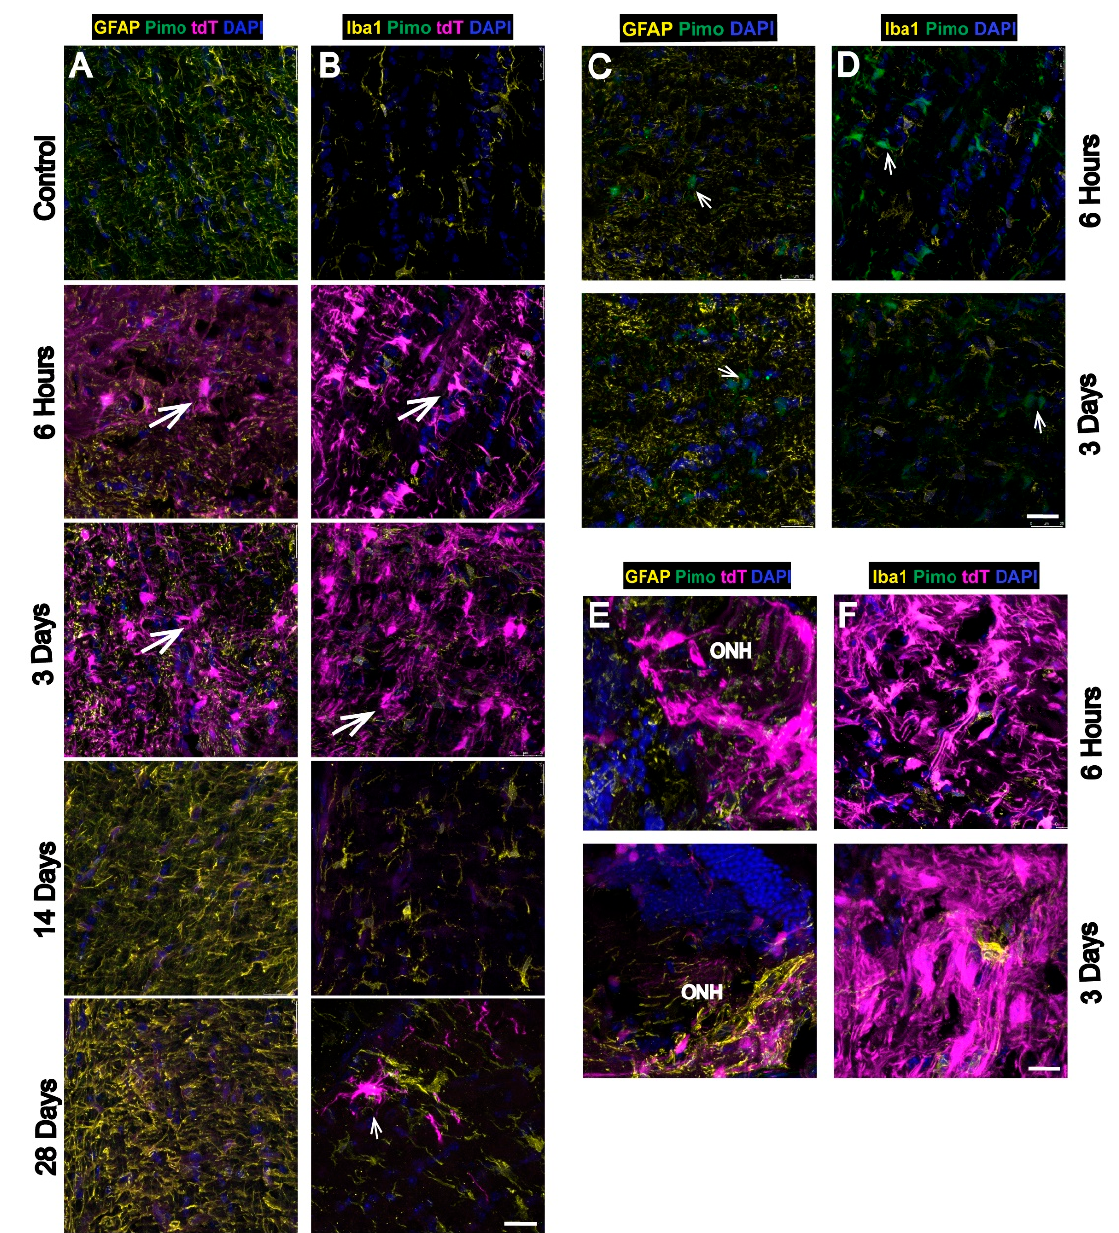
Figure 5. Hypoxic glia in the ON and ONH after OHT. Sections oriented so the globe is superior. Longitudinal sections of ON showed hypoxic glia detected 6 h, 3 d, 28 d after OHT by tdT expression colocalized with GFAP (yellow) in astrocytes (( A ), arrows) and Iba-1 (yellow) in microglia (( B ), arrow) compared with control. Pimonidazole-positive glial cells (pimo, green, arrows) were shown colocalized with GFAP in astrocytes ( C ) and with Iba1 in microglia ( D ) 6 h and 3 days after OHT. Pimonidazole was shown separately since tdT expression overrode pimonidazole labeling in A , B . ONH showed higher intensity of tdT expression than ON 6hrs and 3d after OHT, which colocalized with GFAP in astrocytes ( E ) and with Iba-1 in microglia ( F ). ON: optic nerve, and ONH: optic nerve head. Pimonidazole (pimo, green), tdT = tdT expression (magenta), DAPI (cell nuclei, blue). Scale bar: 25 µ m. n = 6 ONHs and ONs at 6 h, 6 ONHs and ONs at 3 d, 6 ONHs and ONs at 14 d, 6 ONHs and ONs at 28 d, and 6 control ONHs and ONs.